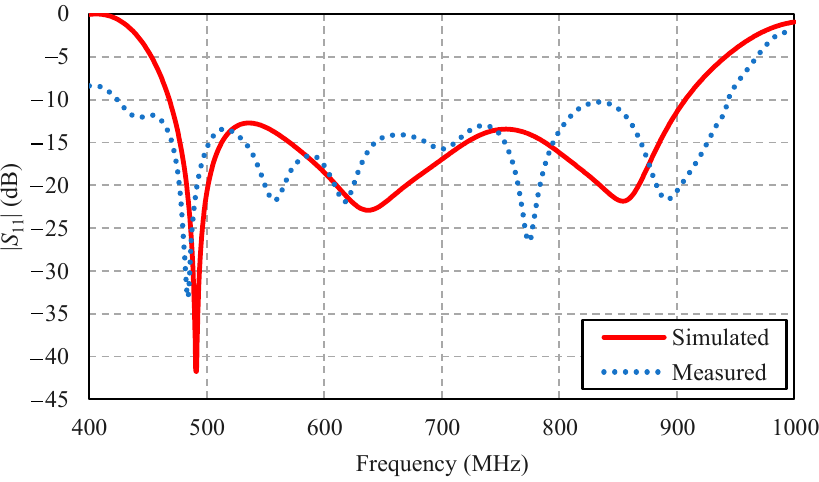
Figure 17. Simulated and measured impedance bandwidths of the portable wideband directional antenna scheme.